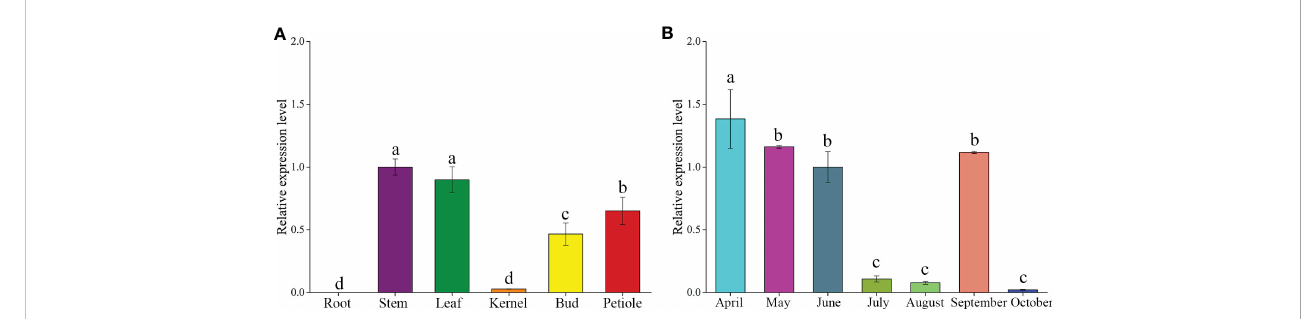
FIGURE 1 Analysis of temporal and spatial expression levels of the GbFLSa gene via RT – qPCR. (A) . Expression patterns of GbFLSa in different ginkgo tissues. (B) GbFLSa expression in the leaves of ginkgo in different months (from April to October). The y-axis represents the relative expression level, the x-axis of (A) represents different tissues, and the x-axis of (B) represents different